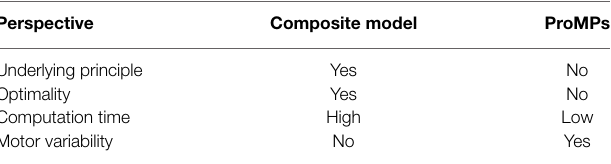
TABLE2 | DifferentperspectivesofthecompositemodelpredictionandtheProMPs prediction.